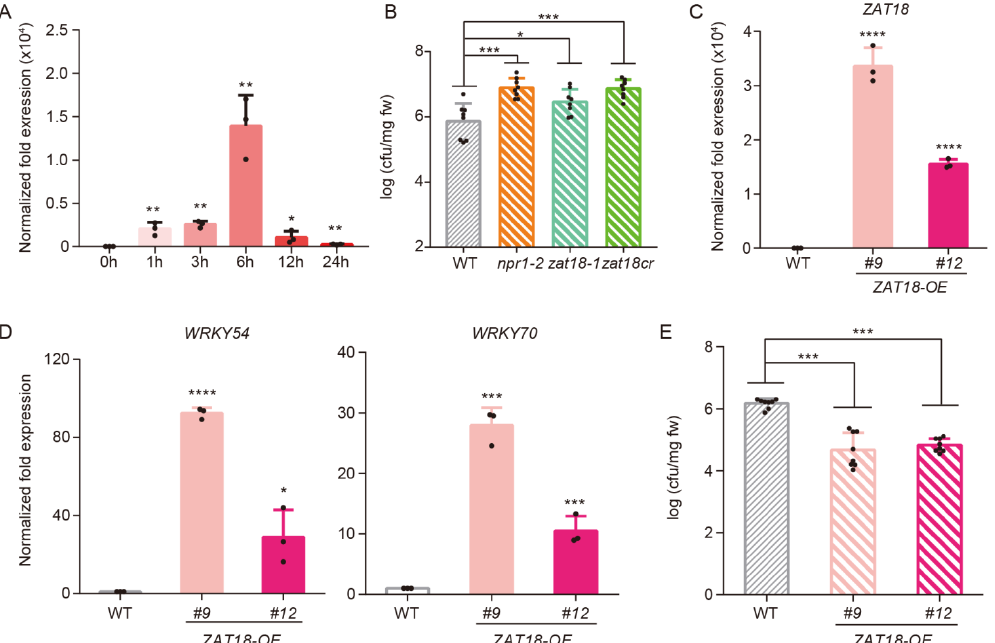
Figure 3. ZAT18 enhances the plant defense against Psm ES4326. ( A ) Three-week-old wild-type (WT) seedlings were infiltrated with Psm ES4326 (OD 600nm = 0.001) and samples were collected at indicated time points to examine the expression levels of ZAT18 with UBQ5 as a reference. n = 3, n indicates the number of biological replicates. ( B ) Three-week-old WT and npr1-2 and zat18 mutants were sprayed with Psm ES4326 (OD 600nm = 0.01) and the third to sixth true leaves were collected to measure the bacterial titer at 3 dpi. cfu, colony forming unit. n = 8, n indicates the number of biological replicates. ( C , D ) The expression levels of ZAT18 ( C ) and WRKY54 and WRKY70 ( D ) in three-week-old WT and ZAT18-OE seedlings without any treatment. n = 3, n indicates the number of biological replicates. ( E ) Three-week-old WT and ZAT18-OE lines were sprayed with Psm ES4326 (OD 600nm = 0.1) and the third to sixth true leaves were collected to measure the bacterial titer at 3 dpi. cfu, colony forming unit. n = 8, n indicates the number of biological replicates. * p < 0.05; ** p < 0.01; *** p < 0.001; **** p <